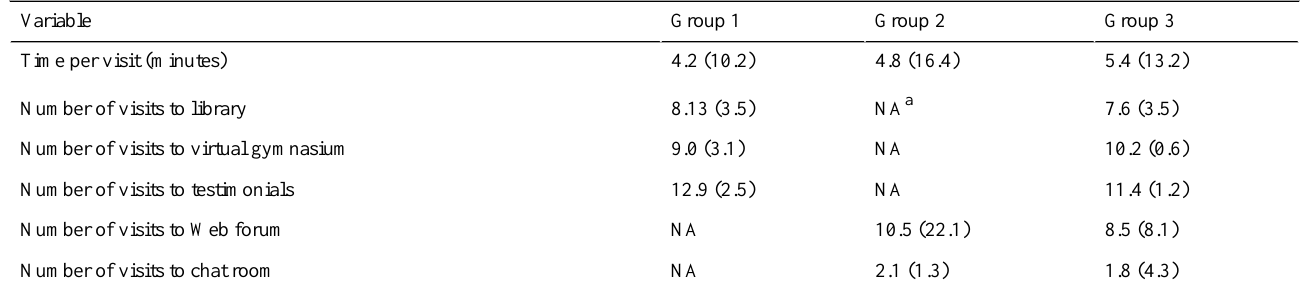
Table 3. Usage data (mean, SD) across experimental